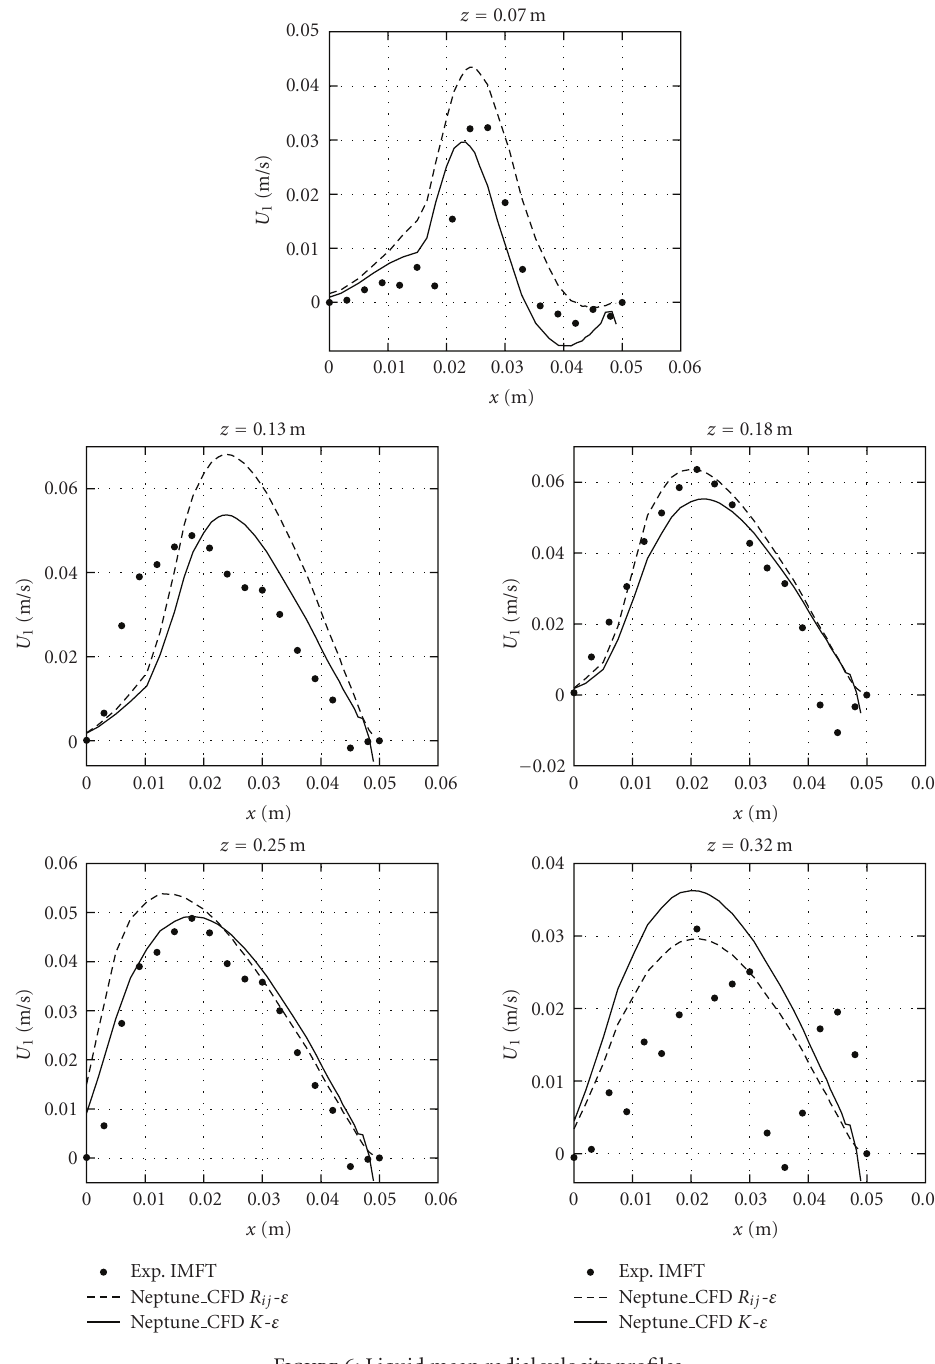
Figure 6: Liquid mean radial velocity